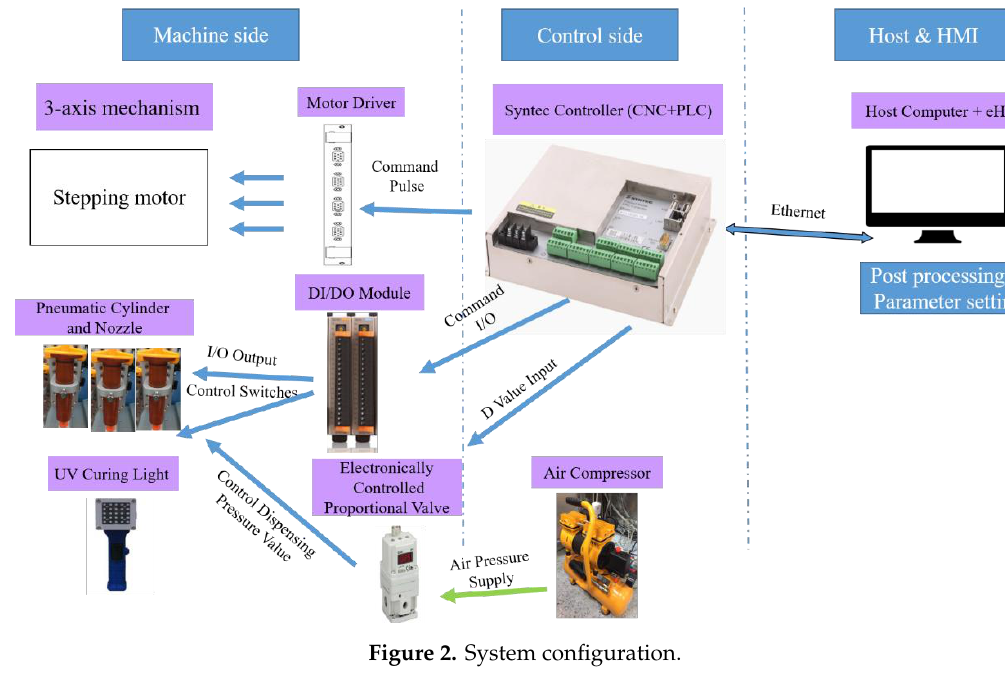
Figure 2. System configuration.